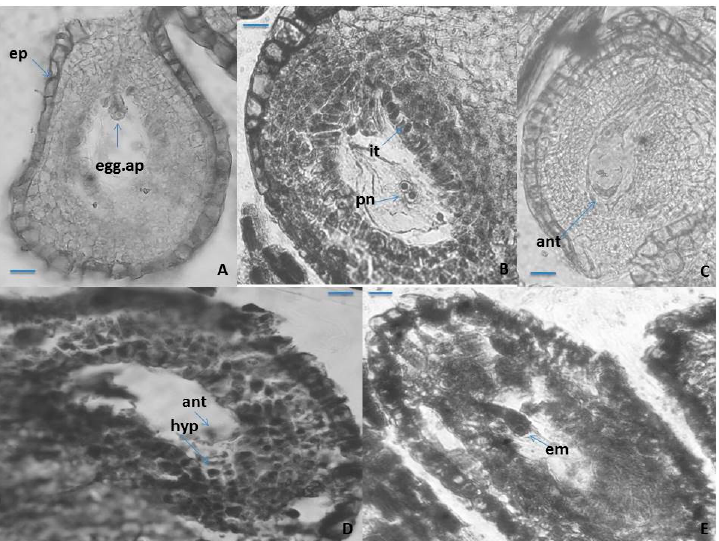
Figure 3. Ovule and female gametophyte development. ( A ) An ovary with ovules, style and stigma, ( B ) unicellular archesporium in a young ovule, ( C ) two-cellular archesporium in an ovule, ( D ) two-nucleate Polygonum -type ES and ( E ) Four-nucleate Polygonum -type ES. ov—ovule; ps— ovary; st—style; al—anther locule; ac—archesporium cell; mt—megaspore tetrad; 2nES—two- nucleate ES; 4nES—four-nucleate ES. Scale bar = 100 μ m ( A ); 50 μ m ( B , C ); 20 μ m ( D , E ).